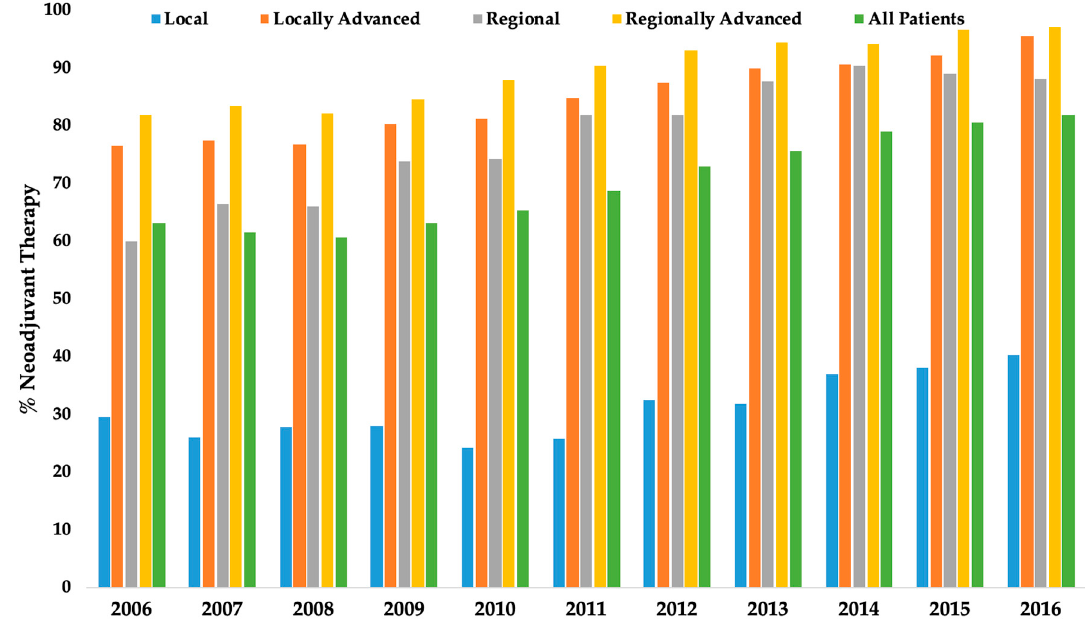
Figure 1. The use of neoadjuvant therapy (chemotherapy, radiation therapy, chemoradiation) by clinical stage from 2006 to 2016 for patients who underwent resection for gastroesophageal junction adenocarcinoma. Table 3. Logistic regression analysis for factors associated with receiving NAT vs. surgery